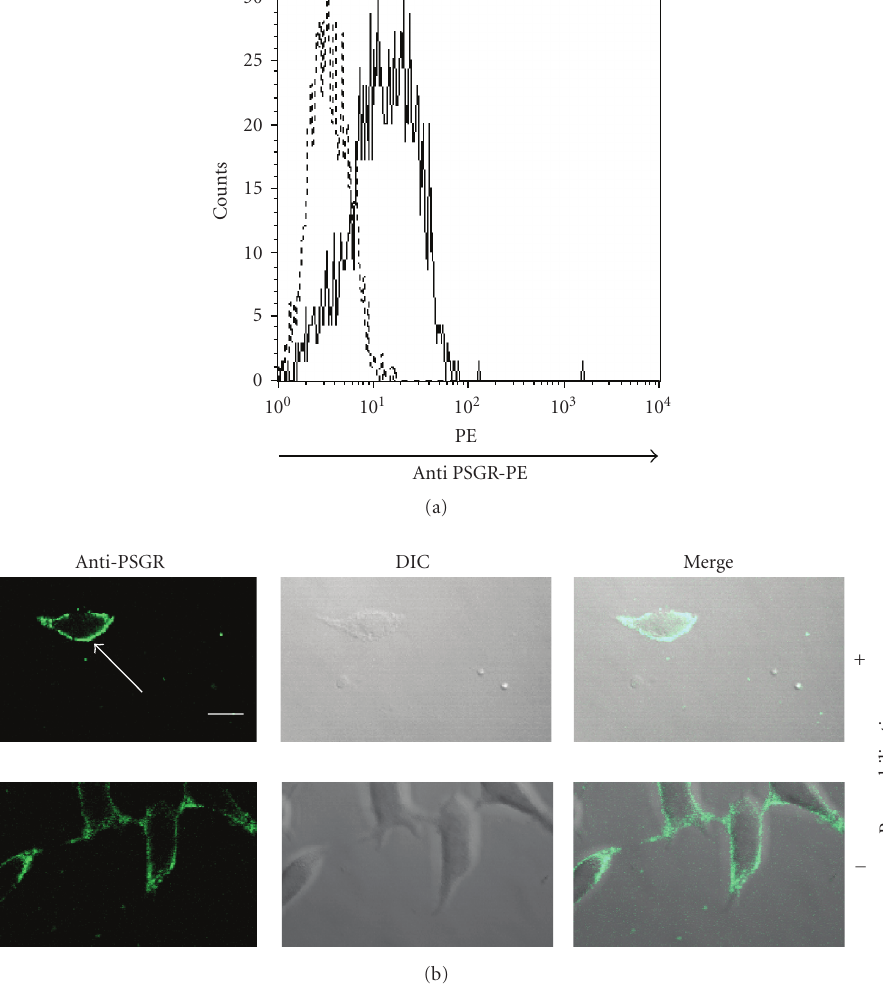
Figure 3: hPSGR immunization. (a) hPSGR expression in LNCaP cells using flow cytometry analysis. Solid line: anti-PSGR serum. Dashed line: preimmune serum. (b) Immunofluorescent staining of LNCaP cells using anti-PSGR serum. Arrow indicates a stained cell. Scale bar = 20 μ